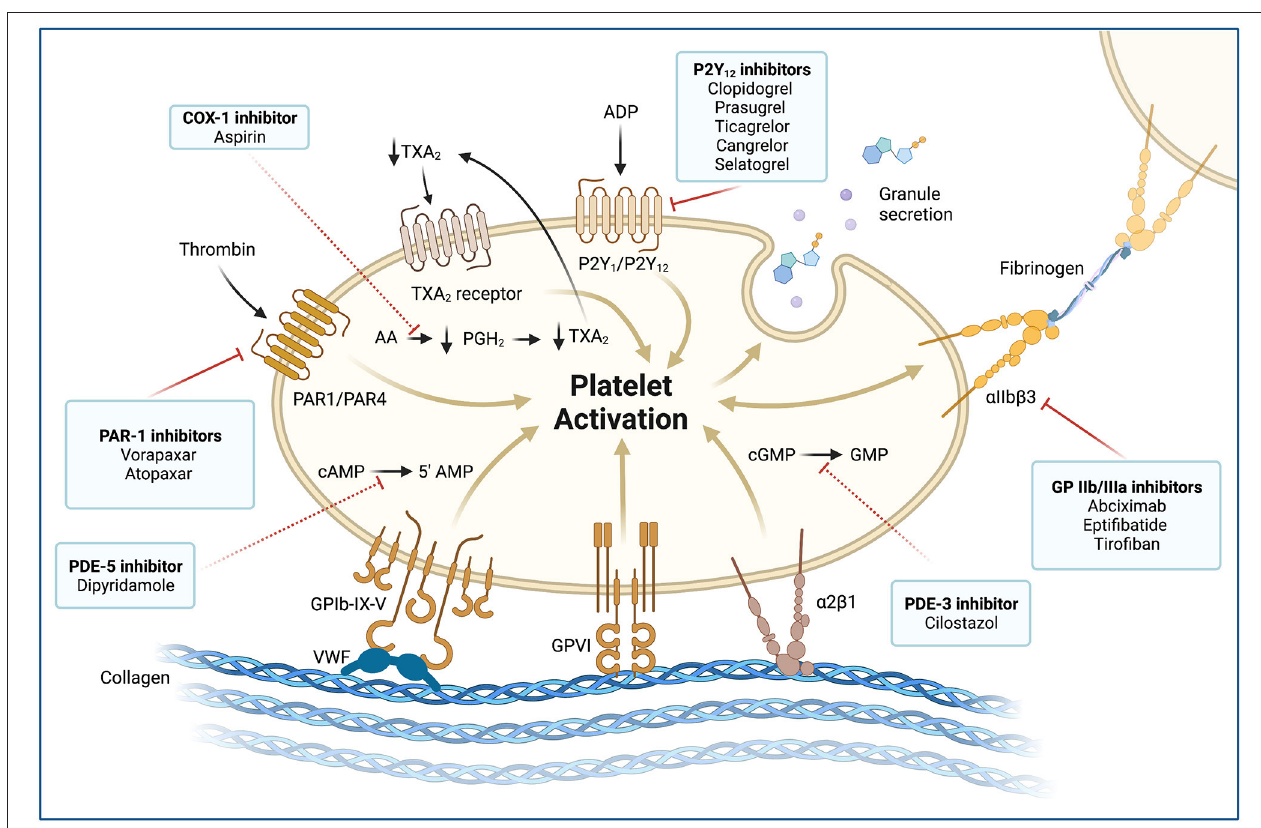
FIGURE 4 | Platelet activation and molecular targets of antiplatelet agents. Antiplatelet agents and their molecular targets are shown in boxes. Blockade of membrane receptors ( continuous red lines ): Oral (clopidogrel, prasugrel, and ticagrelor) and parenteral (cangrelor and selatogrel) P2Y 12 inhibitors block the P2Y 12 receptor, which is a chemoreceptor for adenosine diphosphate (ADP). P2Y 12 receptors produce a potent positive feedback loop for platelet activation. Glycoprotein (GP) α IIb β 3 inhibitors (abciximab, eptifibatide, and tirofiban) are potent parenteral antiplatelet agents. The α II β 3 receptor is an integrin complex that is activated by platelet conformational change induced by ADP stimulus. When the α II β 3 receptor is activated, it binds to fibrinogen and forms platelet aggregates. Proteinase-activated receptor 1 (PAR1), also called coagulation factor II (thrombin) receptor, is a G protein-coupled that plays a key role in mediating the interplay between coagulation and inflammation. PAR1 inhibitors (vorapaxar) are oral potent antiplatelet agents that inhibit the PAR1 receptor and thrombin-related platelet aggregation. Blockade of intracellular signaling pathway ( red dashed lines ): Low-dose oral aspirin exerts its effect primarily by inhibiting the cyclooxygenase (COX-1) and interfering with the cytosolic metabolism of arachidonic acid (AA) into prostaglandin H 2 (PGH 2 ) and thromboxane A 2 (TXA 2 ). TXA 2 stimulates the thromboxane receptor, inducing platelet activation, which results in platelet-shape change, inside-out activation of integrins, and degranulation. The cytosolic reduction of TXA 2 concentration reduces circulating TXA 2 availability and TXA2 receptor stimulation. Phosphodiesterases (PDEs) can limit the intracellular levels of cyclic nucleotides and regulate platelet function by catalyzing the hydrolysis of cyclic adenosine 3’,5’-monophosphate (cAMP) and cyclic guanosine 3’,5’-monophosphate (cGMP). Dipyridamole is an oral antiplatelet agent that inhibits the PDE5 and 5’AMP production. In contrast, cilostazol is a PD3 inhibitor that blocks GMP production. MINOCA: myocardial infarction with non-obstructive coronary arteries; vWF, von Willebrand factor; GPIb-IX-V, Glycoprotein Ib-IX-V complex; GPVI, Glycoprotein VI; α 2 β 1, Integrin α 2 β